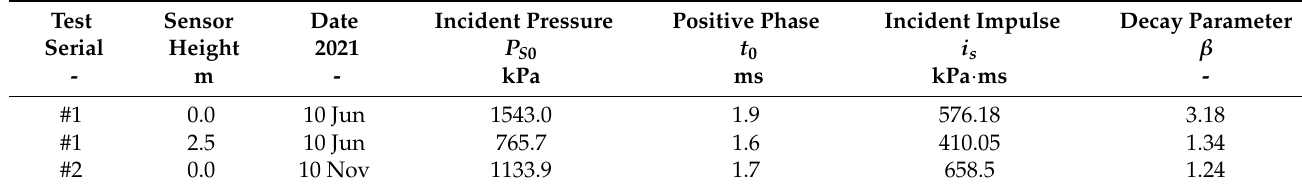
Table 2. Overpressures measured during the blast tests and adjusted decay parameter.